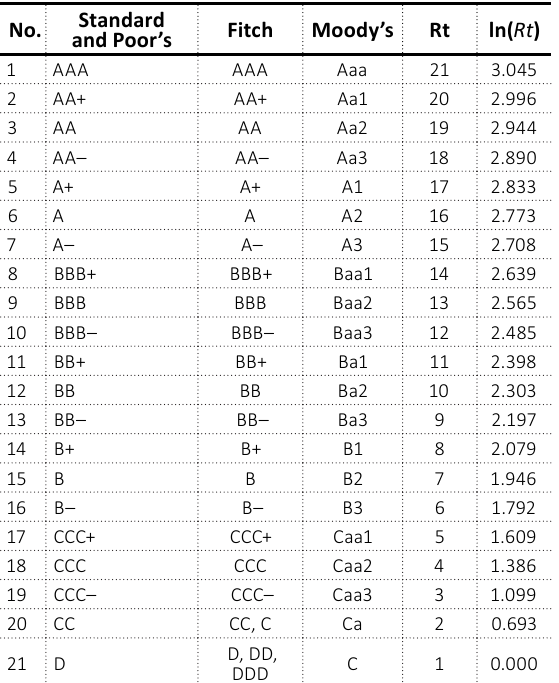
Table 1. Non-linear assignment of numeric values to credit rating